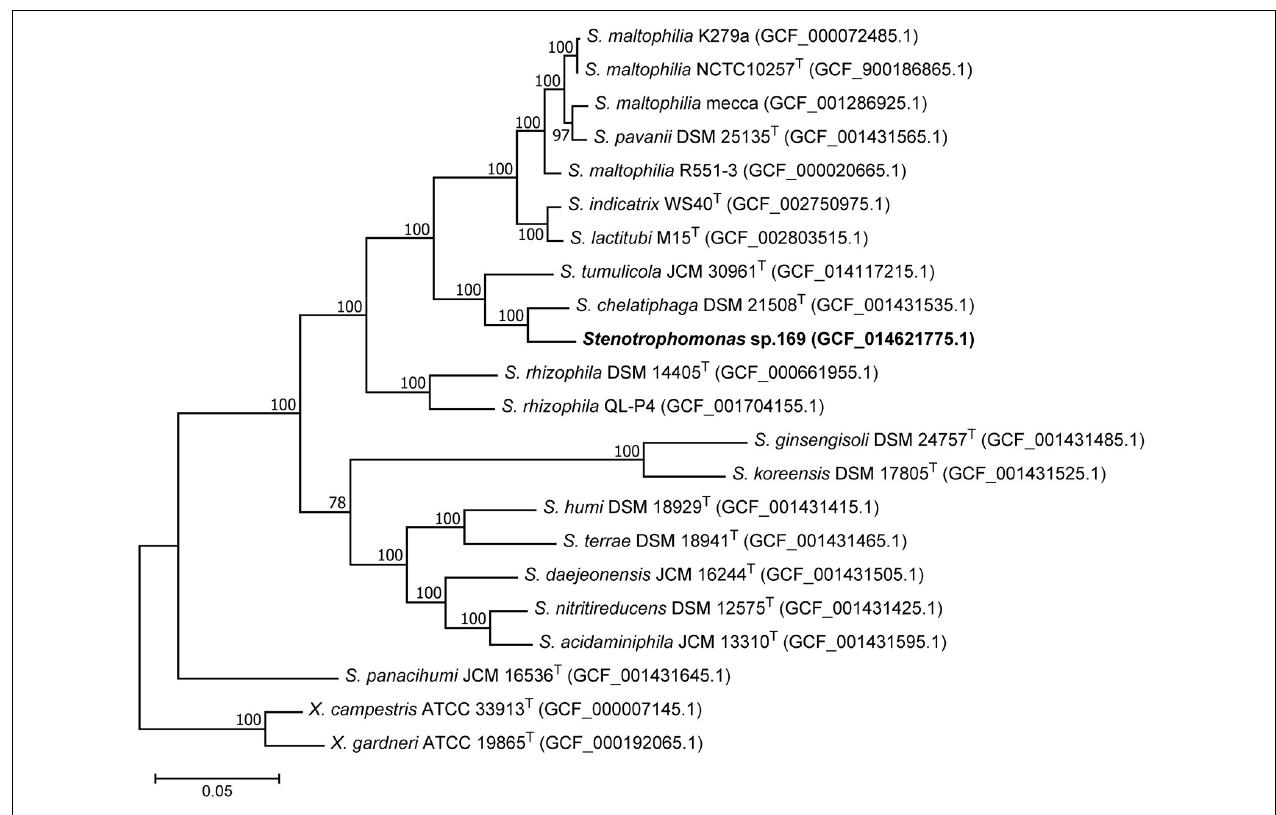
FIGURE 4 | Phylogenomic tree showing the position of Stenotrophomonas sp. 169 among type strains and other reference strains of closely related Stenotrophomonas species. Xanthomonas campestris and Xanthomonas gardneri were used as outgroup. The maximum-likelihood tree is based on concatenated 120 core marker proteins. Numbers at branch nodes refer to bootstrap values > 70%. Bar: amino acid substitutions per position. Assembly accession numbers are indicated in